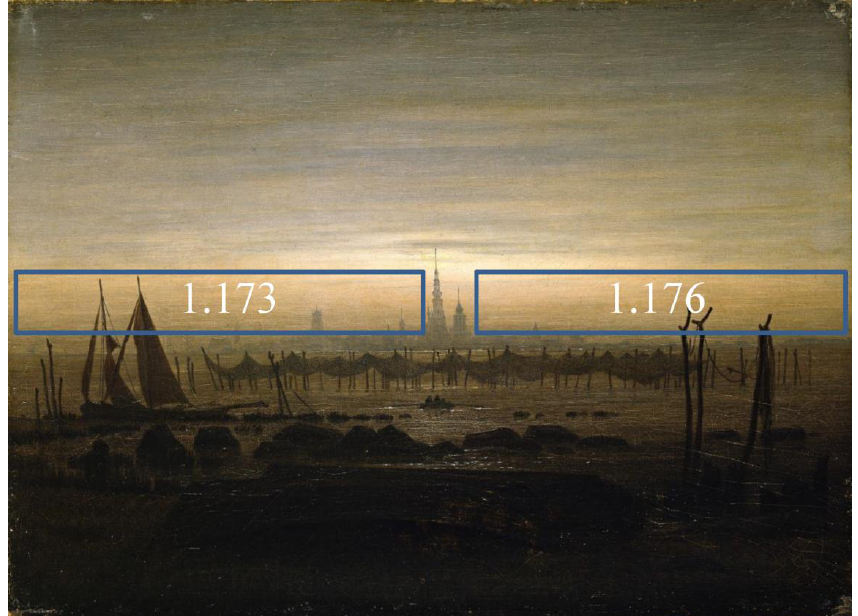
Fig. C1. Caspar David Friedrich, Griefswald in the Moonlight, 1817. Corresponding R/G ratios were averaged inside each